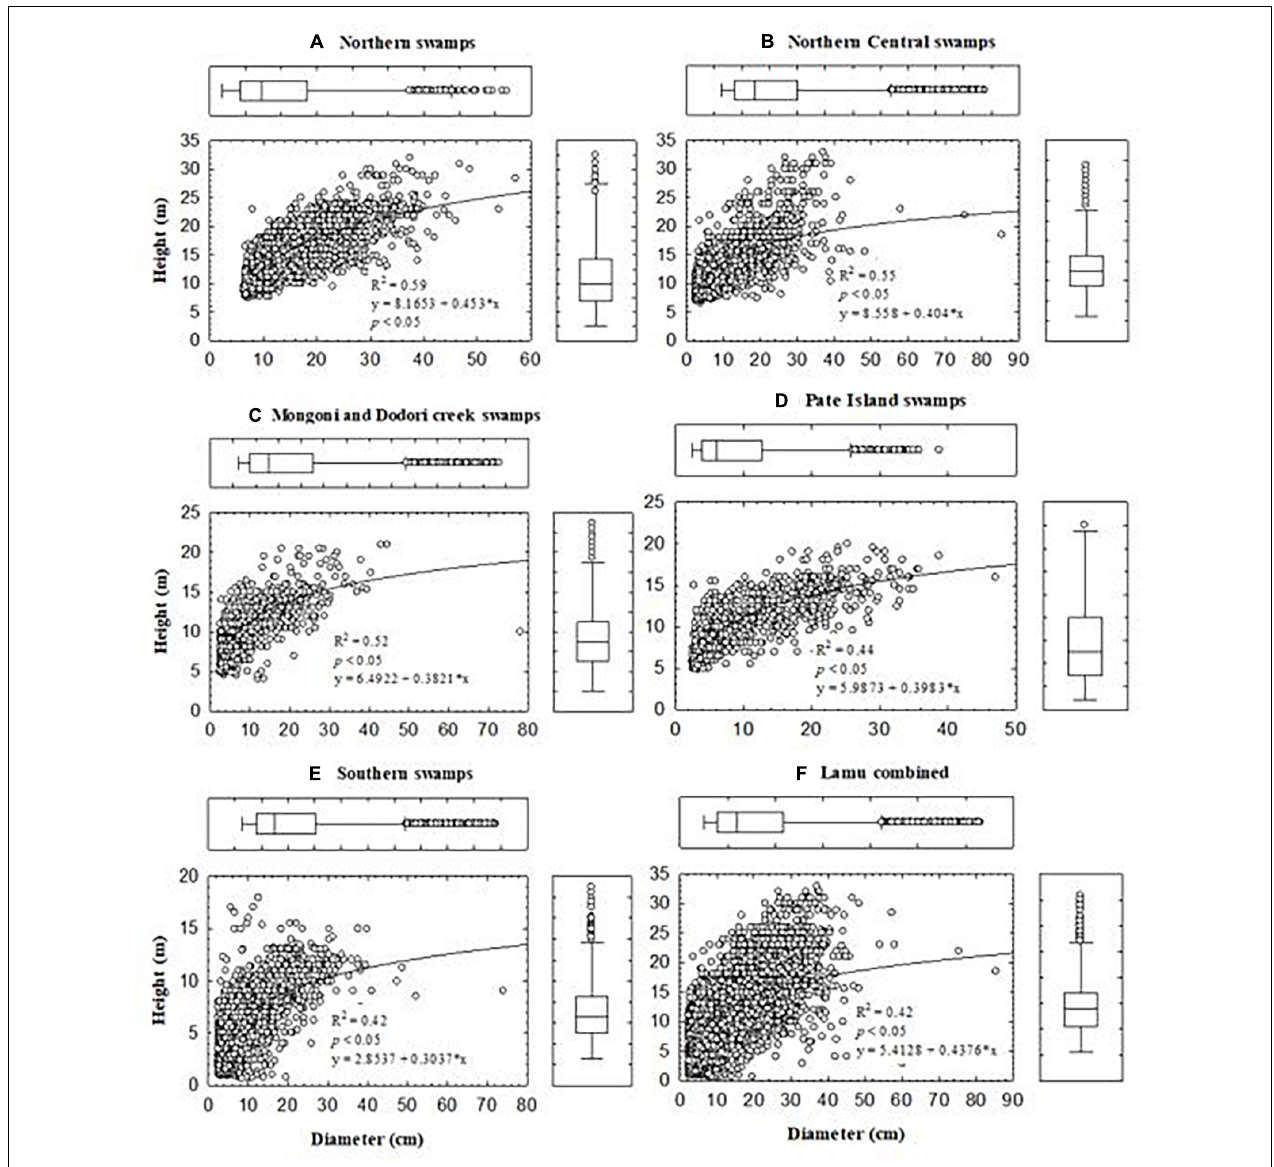
FIGURE 4 | Height – diameter relationships in the five blocks of Lamu mangrove forest (A–E) and the combined ecosystem (F) . The box plots display percentile distribution of the DBH and heights in the forest blocks. The extremities of the plot correspond to the maximum and minimum observations in the data set. The ends of the boxes are positioned at the 25 and 75% percentile of the